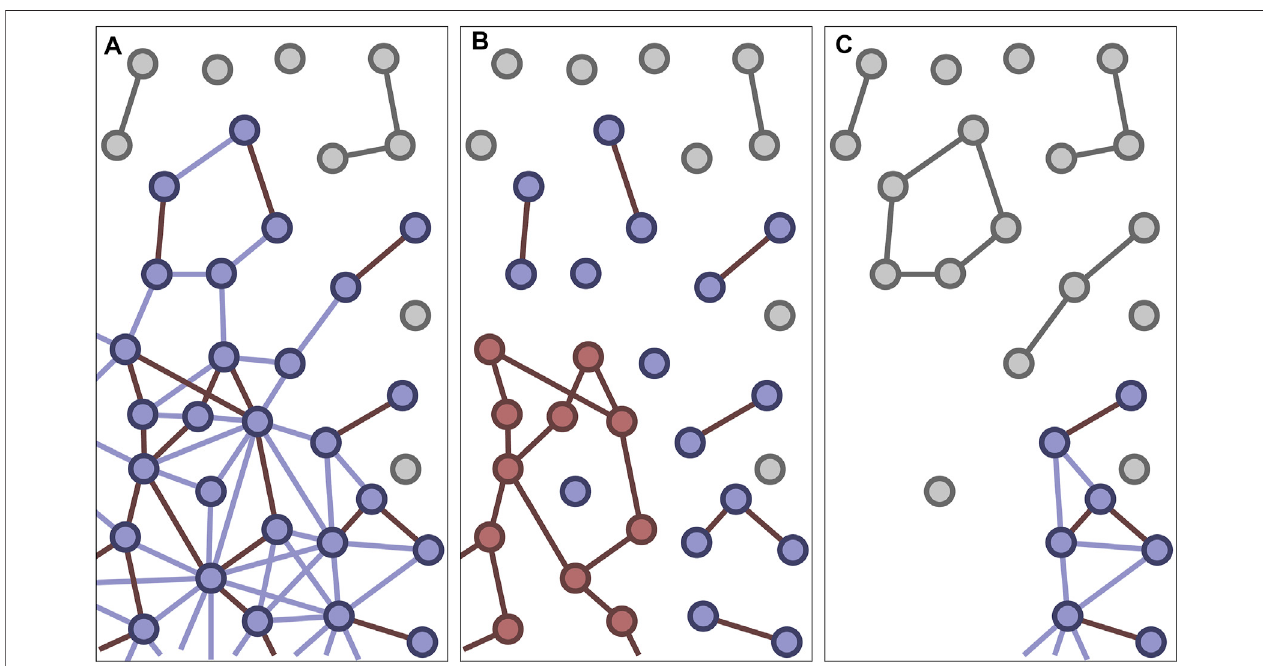
FIGURE4| Illustrationofaviralattack.Beforetheattack (A) someproportionofthenodesandlinksisinthegiantcomponent(colored),whereasothersareinsmall components (grey). We consider a situation where only a small fraction of the links conduct the attack (dark red links, only marked in giant component). To assess the impact ofaviralattack (B) ,weremoveallnon-conductinglinksandcomputethesizeofthegiant conducting component (rednodes).Aftertheattack (C) allnodesinthe giantconductingcomponentandtheirlinkshavebeenremovedfromtheoriginalnetwork.Thegiantcomponentintheremainingnetworkisnowsmallerassomeof its nodes have been destroyed and others have become separated into small